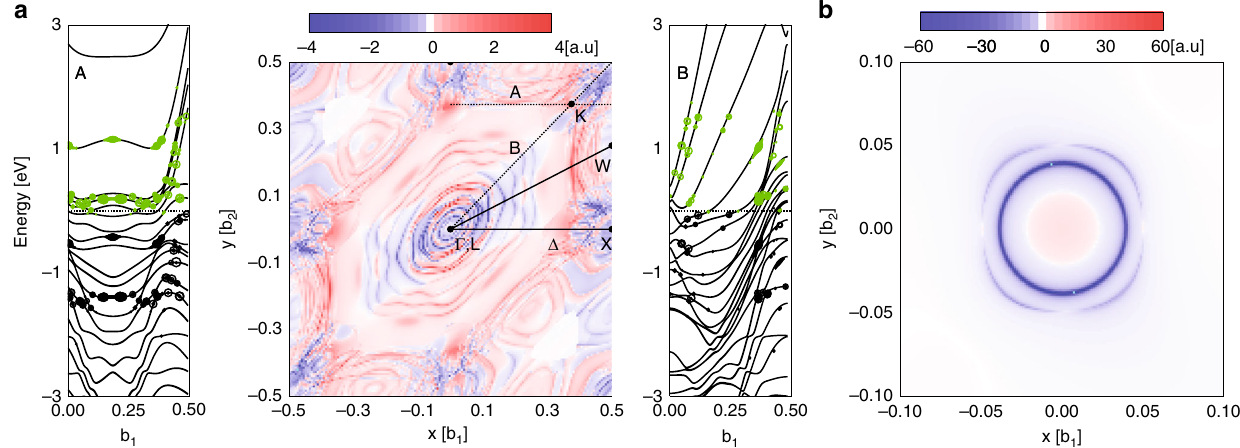
= d t ð Þ (positive value with red and negative value with blue) on the Fig. 4 Theoretical calculation of optical orientation. Optical spin generation rate d s z conduction band in a six layers of [111] Pt and b [111] GaAs in the k space with a continuous light of right-circular polarization ( + ħ ). On the left and right panels of a , we plot energy levels along A and B lines indicated in the center panel and show associated optical transitions where the oscillation strength is proportional to the size of symbols (green symbols for electrons and black symbols for